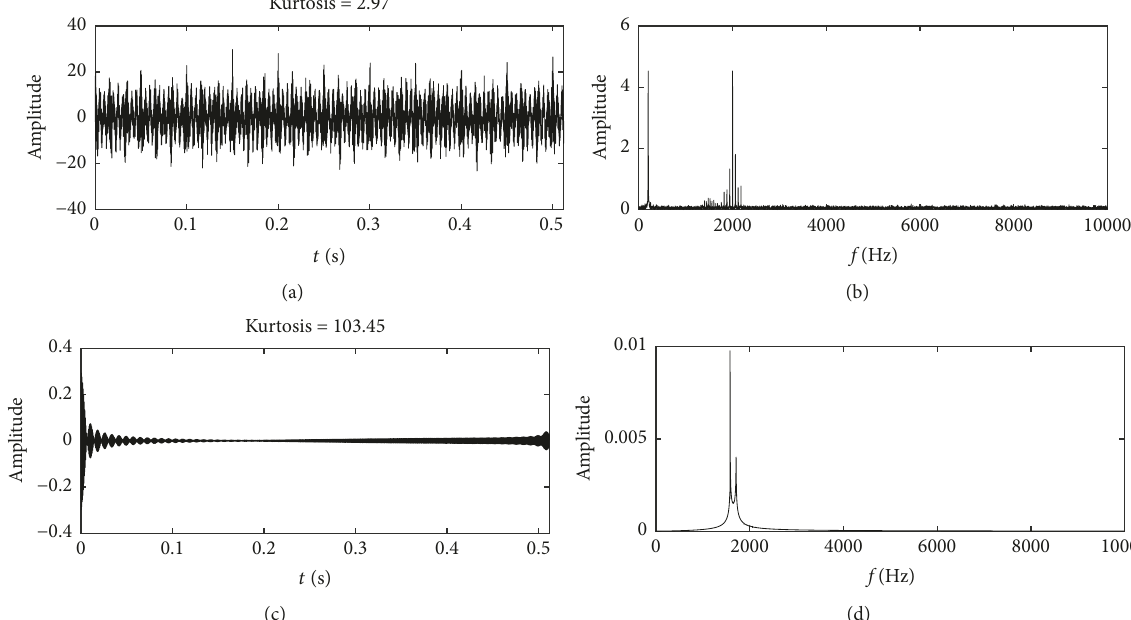
Figure 9: An example to illustrate the large kurtosis value of a subband signal filtered by a narrow bandwidth filter. (a) is the original signal and (c) is the subband signal filtered by a narrow bandwidth filter. (b) and (d) are the spectrum of corresponding (a) and (c).